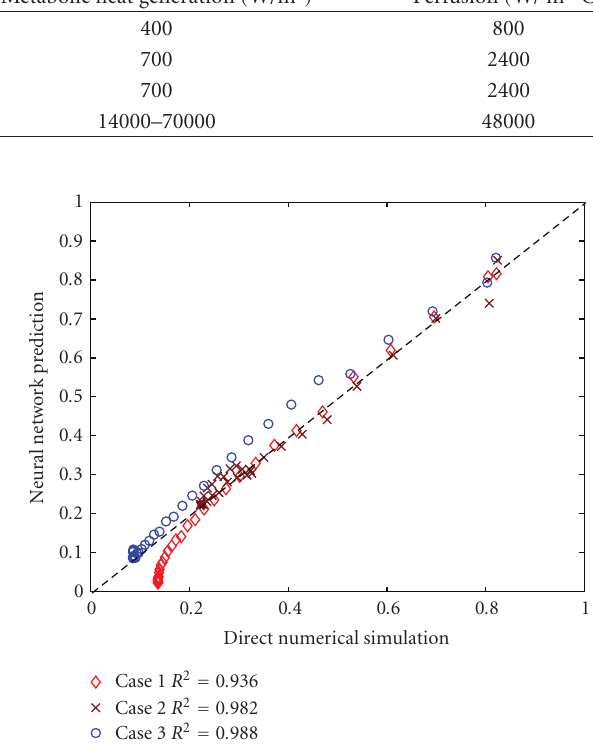
Figure 6: Comparison of output of trained ANN with finite element